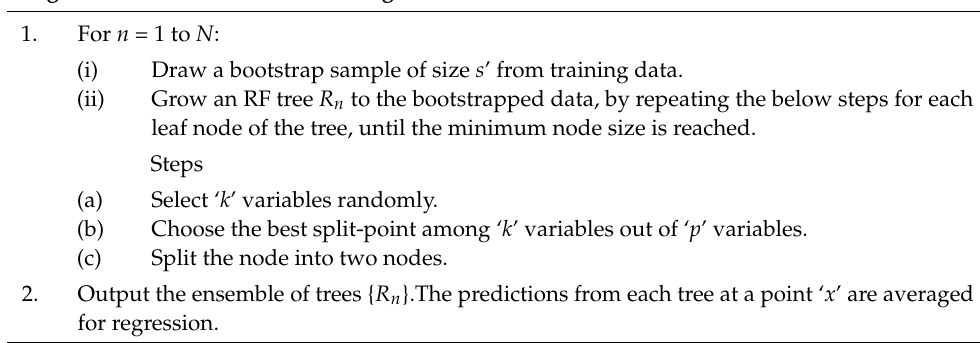
Algorithm 2: Random Forest for